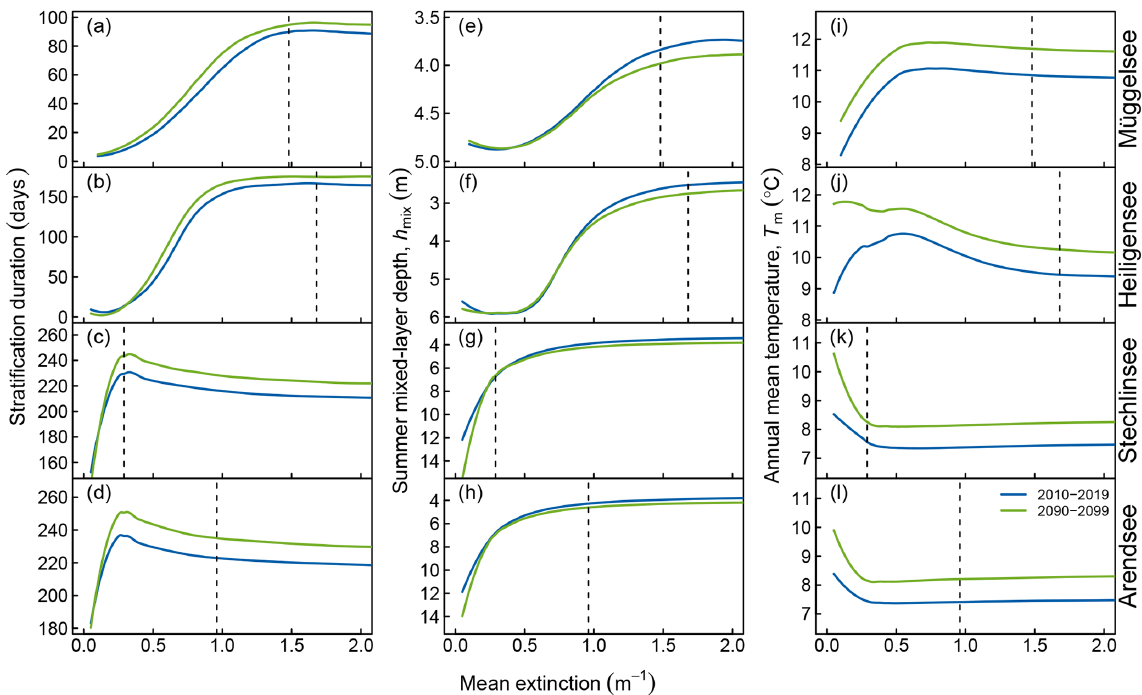
Figure 10. Interacting effects of extinction and warming on stratification duration (a–d) , mean mixed-layer depth in summer (e–h) , and annual mean temperature (i–l) in Müggelsee (a, e, i) , Heiligensee (b, f, j) , Stechlinsee (c, g, k) , and Arendsee (d, h, l) . Lines have been loess- smoothed and show ensemble means for the decades 2010–2019 (blue) and 2090–2099 (green) as a function of extinction. Black vertical dashed lines show the long-term measured extinction in each